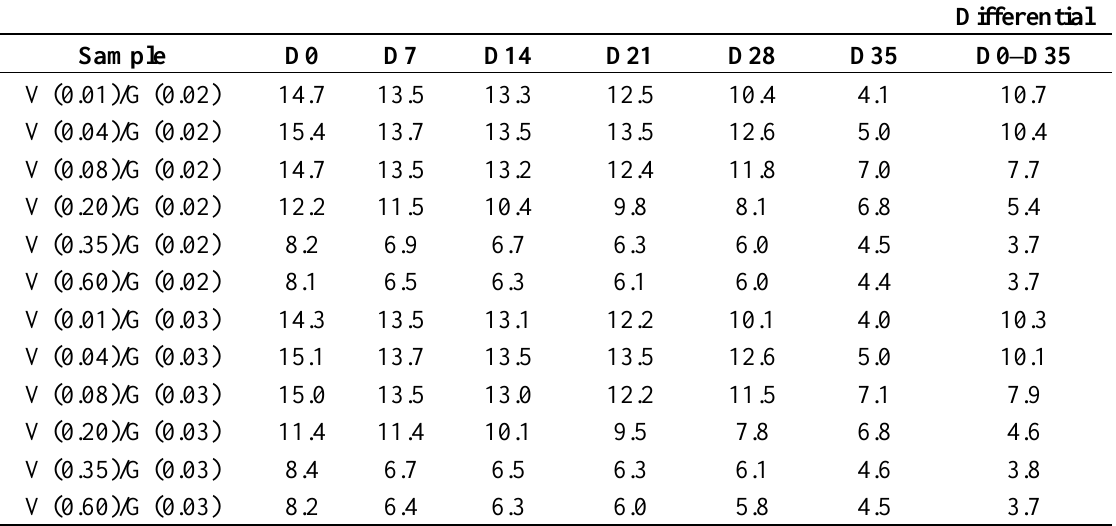
Table 4. Mean O levels (%) found in BS packs held under varying packaging treatments 2 (standard deviation ≤ 0.50%). V—represents the level of vacuum pressure applied (MPa); G—represents the level of gas flushing pressure applied